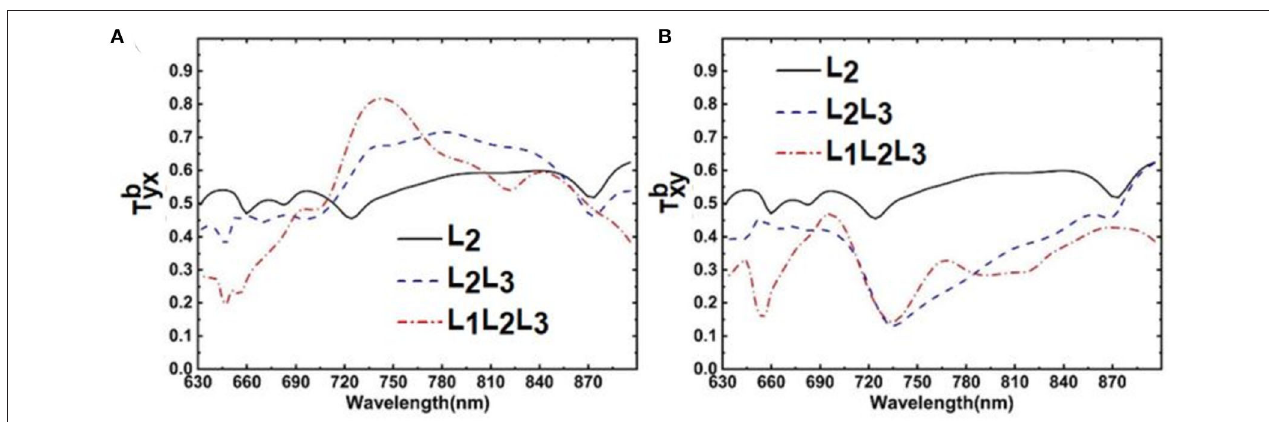
FIGURE 5 | Cross-polarized transmission coefficiency of (A) x -polarized and (B) y -polarized backward propagating light of L 2 , L 2 L 3, and L 1 L 2 L 3 , respectively.